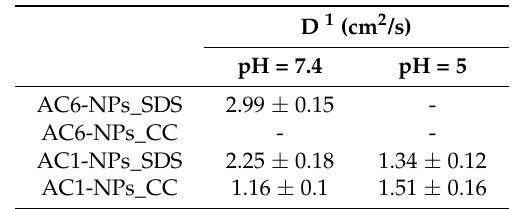
Table 2. Diffusion coefficients (D) of NPs_SDS and NPs_CC from AC6 and AC1 hydrogels at pH = 7.4 and pH =